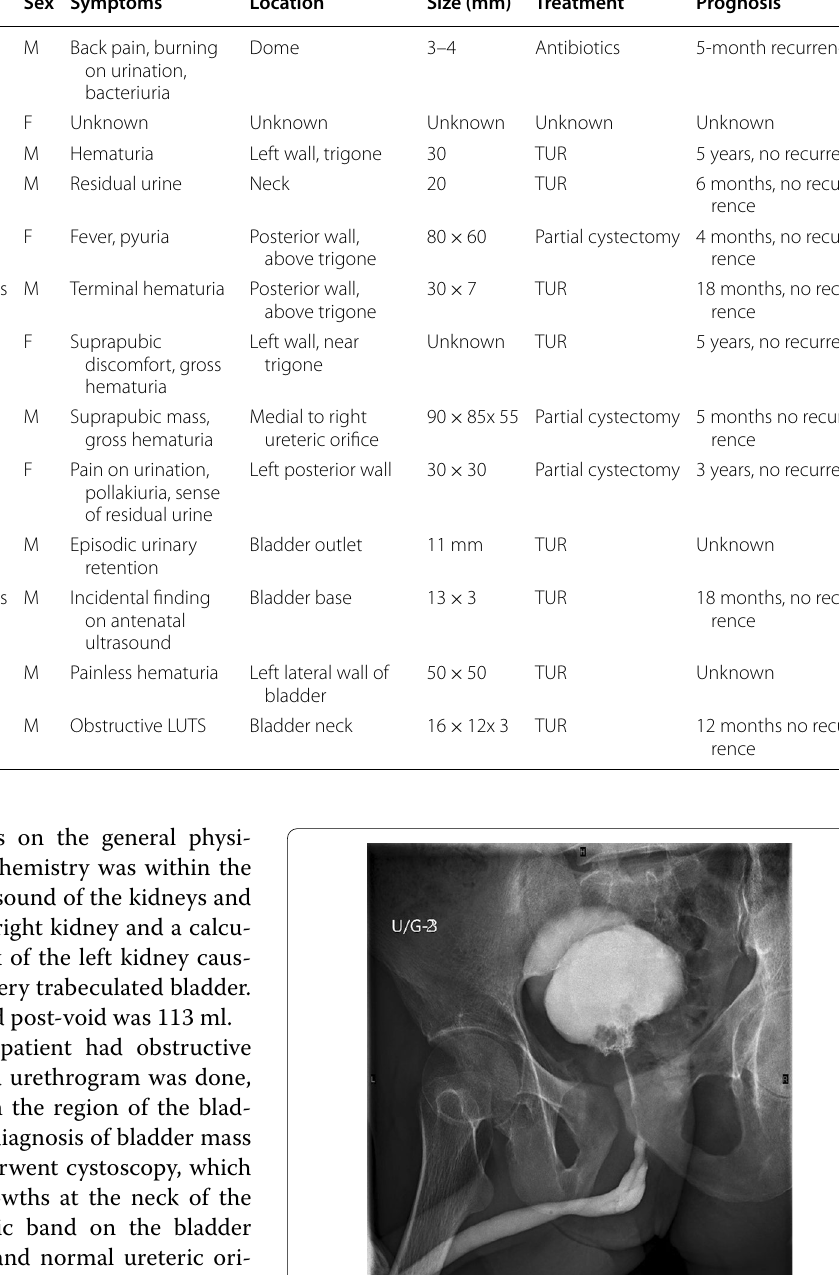
Table 1 Documented cases of bladder hamartoma in the literature. (TUR: transurethral resection) Case (Reference)